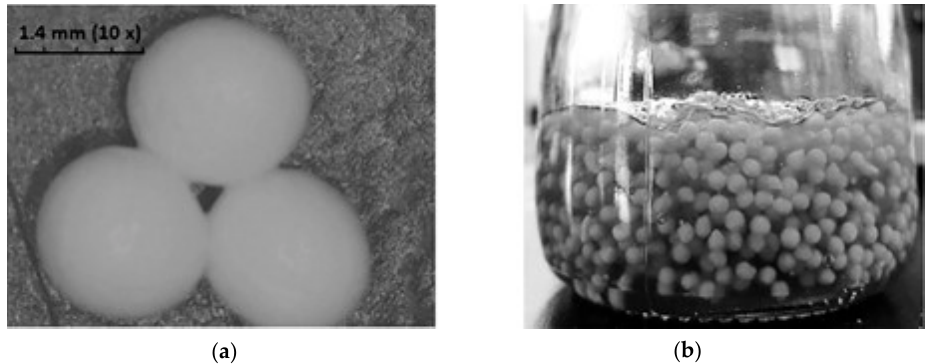
Figure 9. ( a ) Carbamazepine (CBZ)-alginate beads, ( b ) CBZ-gel prepared at a 1:1 ratio of beads to iota carrageenan gel [104].